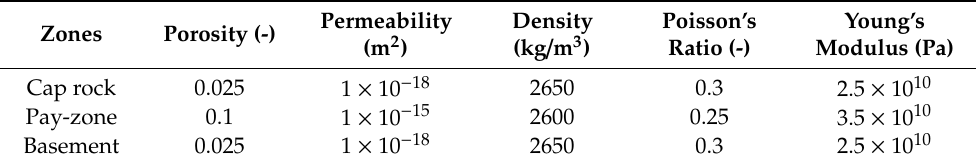
Figure 2 . (a) Schematic of fictive ½ 3D reservoir model with corresponding (b) initialized primary Figure 2. ( a ) Schematic of fictive 1 3D reservoir model with corresponding ( b ) initialized primary 2 stresses and pore pressure. stresses and pore pressure. Table 1. Hydraulic and mechanical properties of the Table 1. Hydraulic and mechanical properties of the model.